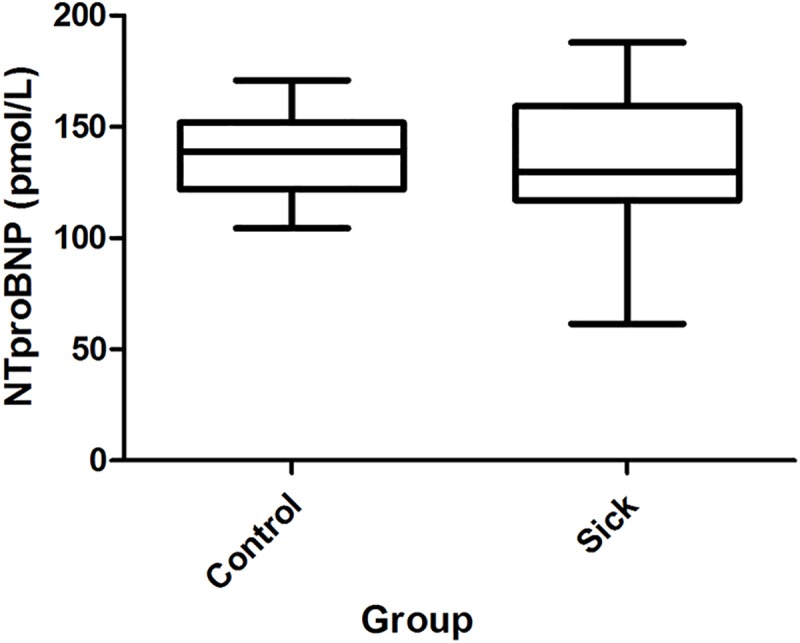
Sample distribution of NT-proBNP concentrations between the groups with the result of the statistical test.